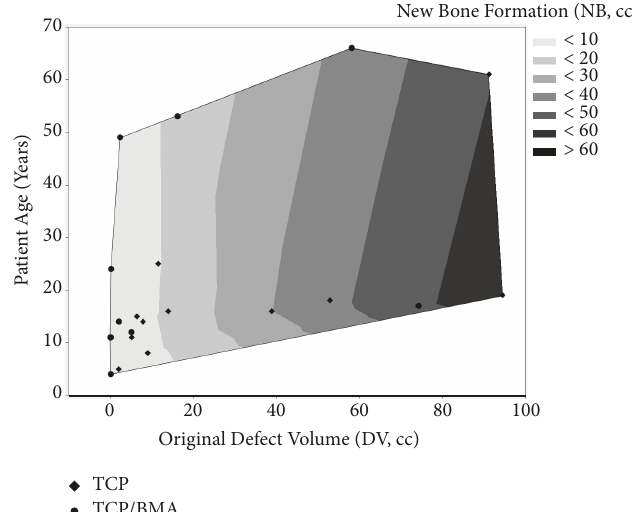
Figure 7: A contour plot of the influence of patient age and original defect volume (DV) on new bone formation (NB). Using a multiple regression model, patients with larger DV had higher NB (p < 0.0001). Increasing age coupled to increasing DV (age ∗ DV) had reduced NB (p=0.0003). NB is TCP/BMA data (diamonds) and TCP data (filled circles) are shown.